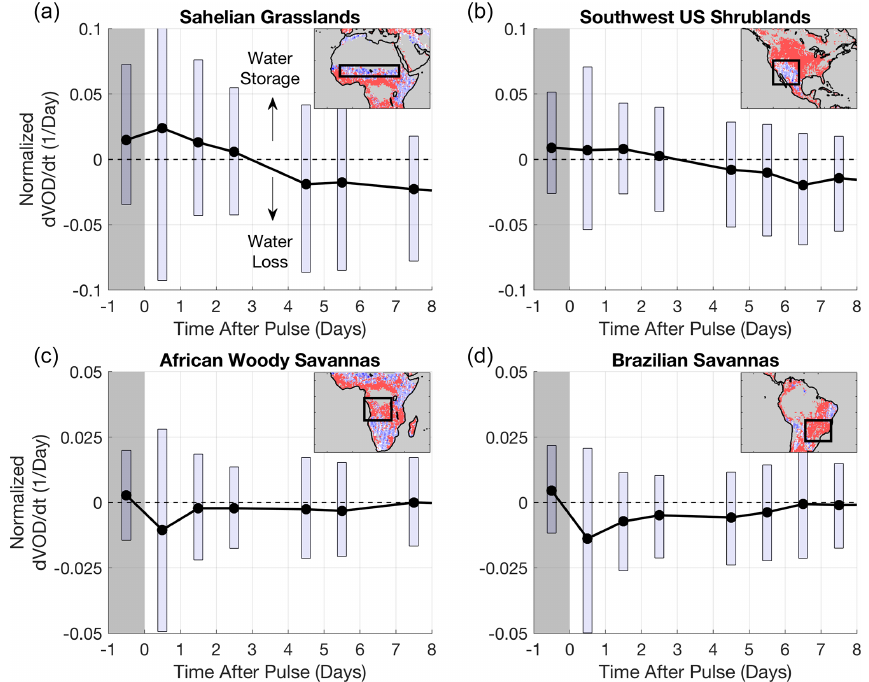
Figure 3. VOD rate of change distribution on a given day after the pulse for regions outlined in the insets. Boxes delineate the interquartile range for each day. dVOD / d t is normalized by dividing by VOD time mean for a given pixel for consistent comparison across regions. dVOD / d t is reported as the average change rate over a given day (for example, from day 0 to day 1). All pixels with the noted dominant land cover ( > 75% IGBP land cover type) are used within the boxed region in the inset to create the distributions for each respective day after the pulse. Gray shading indicates the pulse period when soil moisture is increasing (Fig. 1). At time greater than zero, soil moisture is drying (drydown event; see Fig. 1). Behavior extends beyond a week in many cases, but only 8d following the pulse are shown here. Note that top and bottom panels have different y -axis